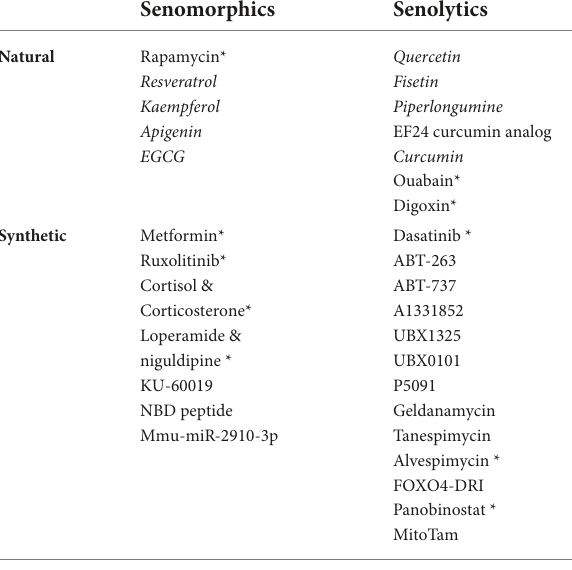
TABLE 2 Summary of natural and synthetic products used as senotherapeutics.